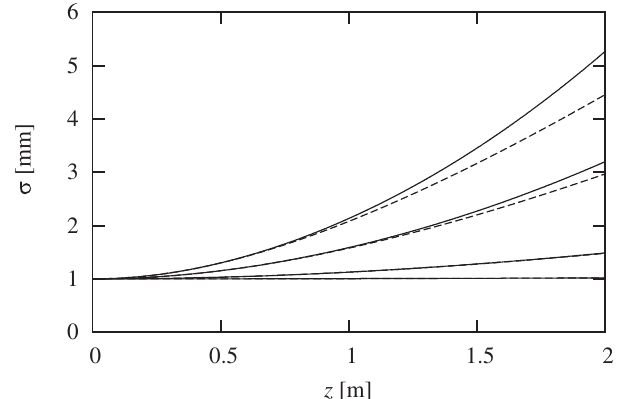
FIG. 3. Development of the beam size in a drift with space charge. Beam ð 10 ; 5 ; 1 ; 0 Þ × 10 − 6 (the highest perveance corresponds to the highest beam divergence). Analytical approximation according to Eq. (8) with coefficients c; … ¼ 0 (solid lines) and results of a numerical integration of Eq. (6) (broken